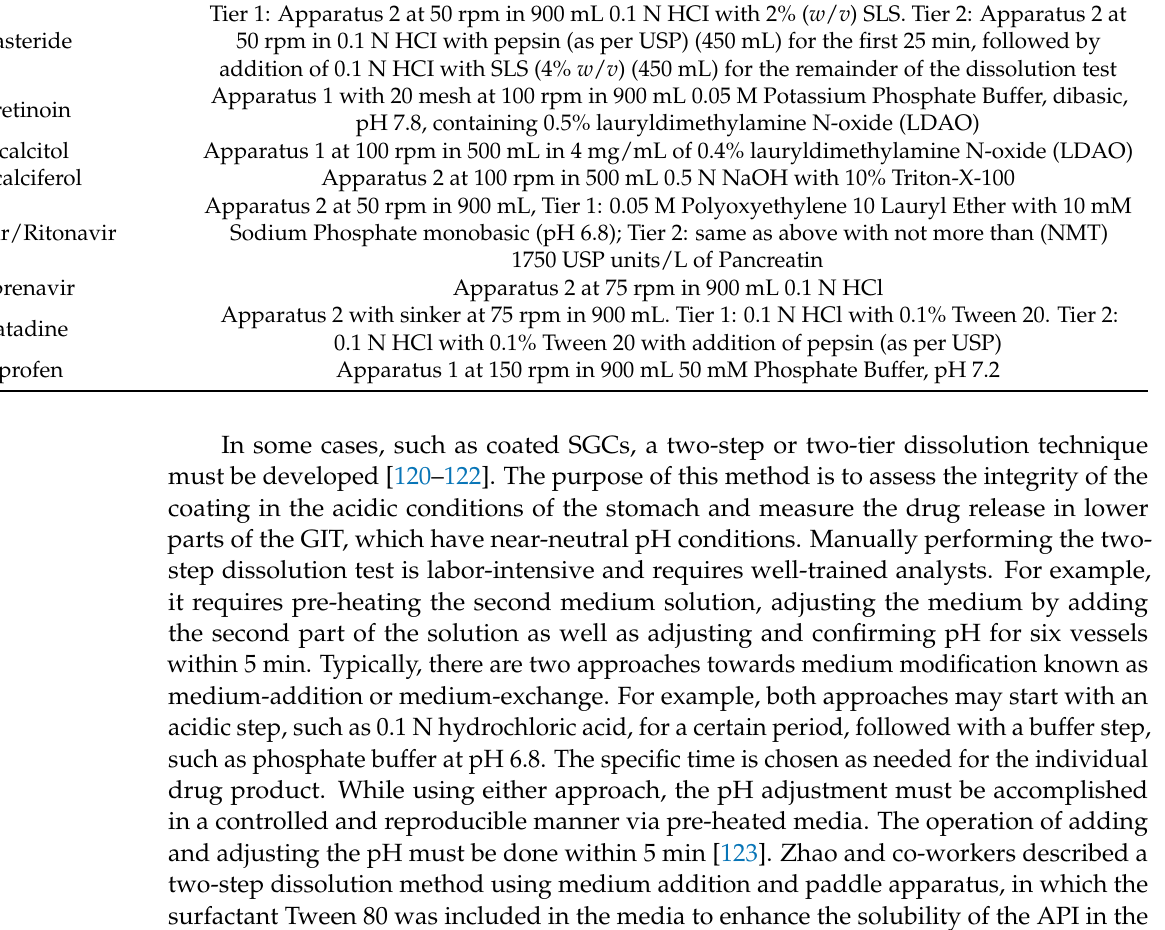
Table 3. Examples of commercially available SGCs and their dissolution methods [119]. Drug Product Information Dissolution Method Cyclosporine (100